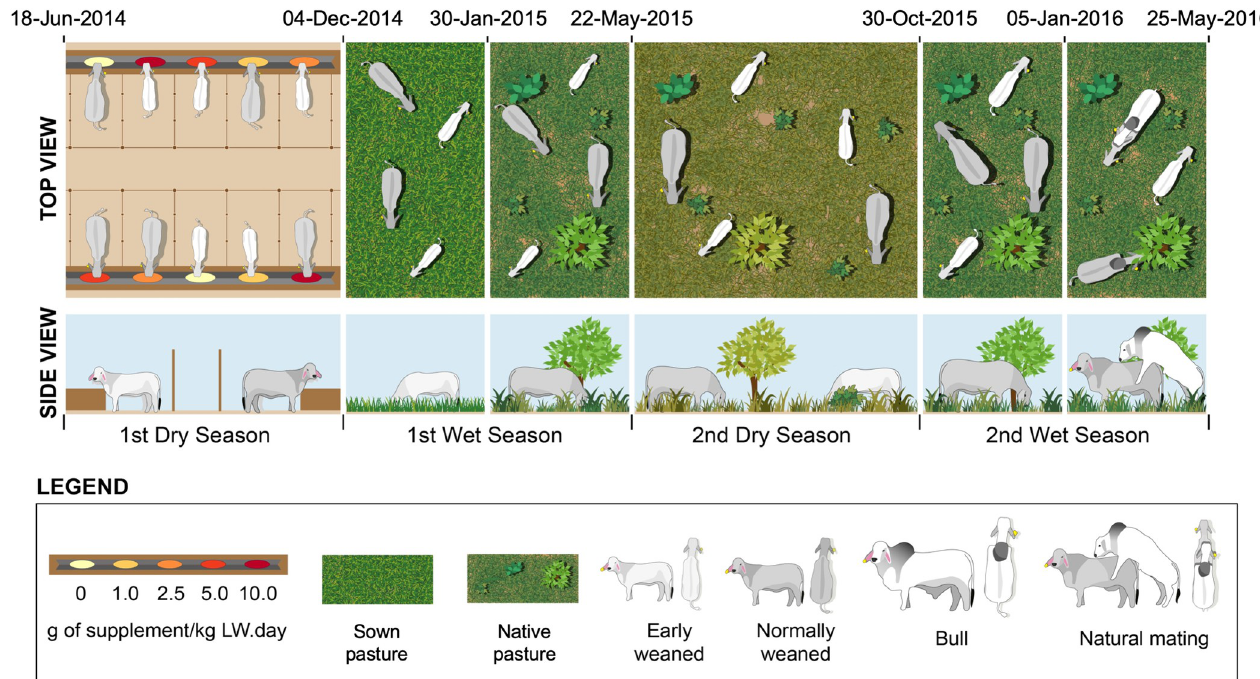
Fig 1. Schematic representation of experimental timeline and animal management during the experiment.